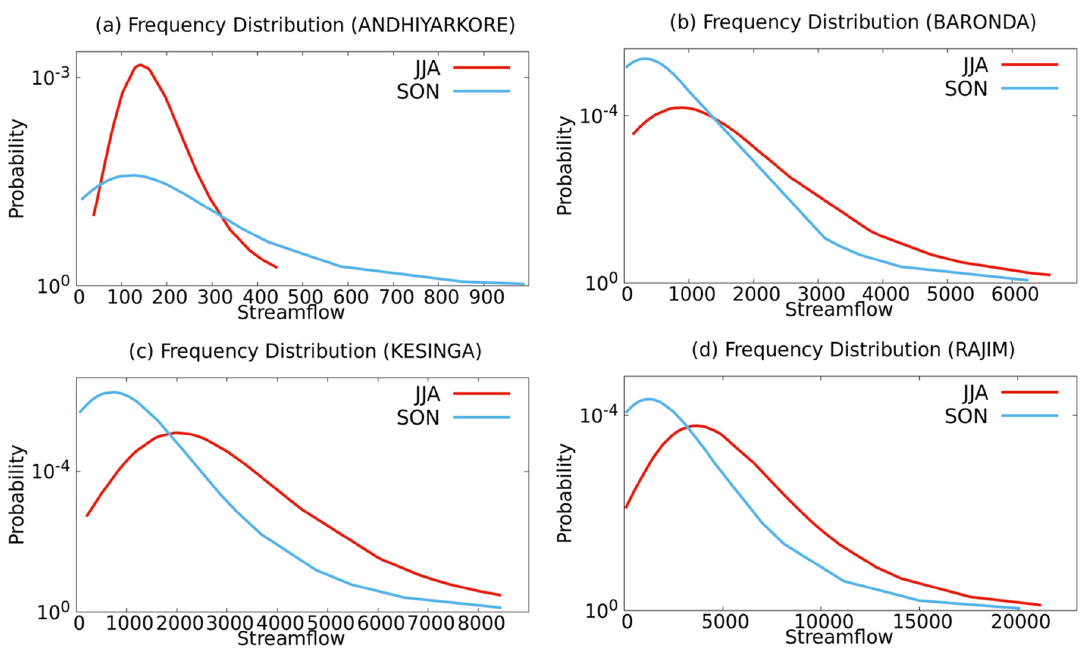
Figure 7. Frequency of annual JJA and SON maximum streamflow (m 3 s − 1 ) with respect to Gumbel distribution.